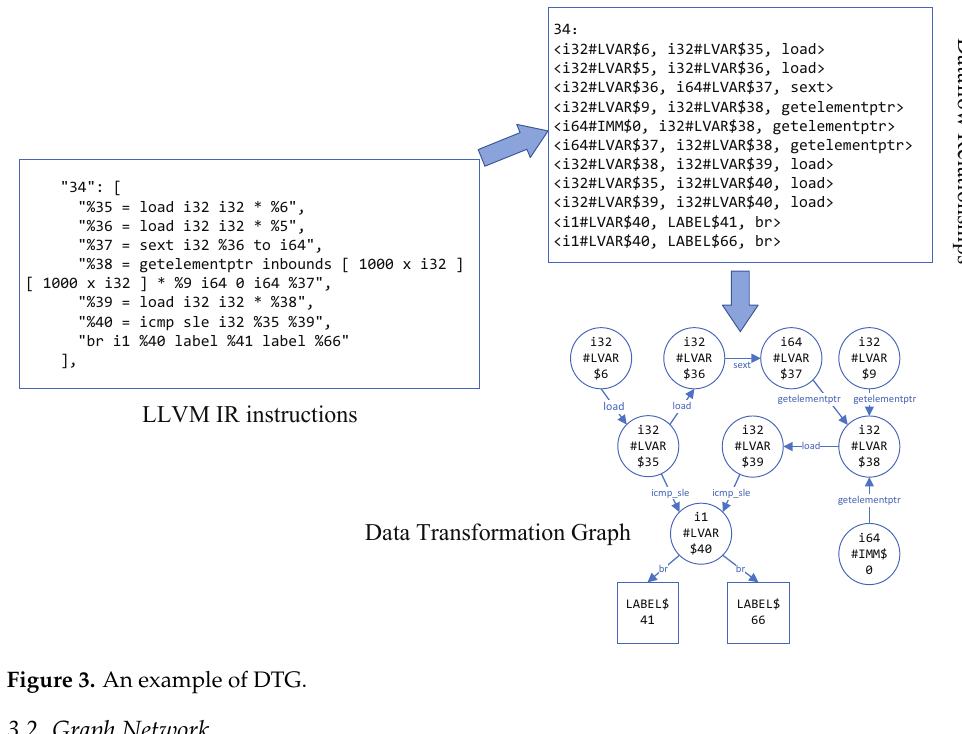
Figure 2. Data flow conversion relationship for different types of instructions.